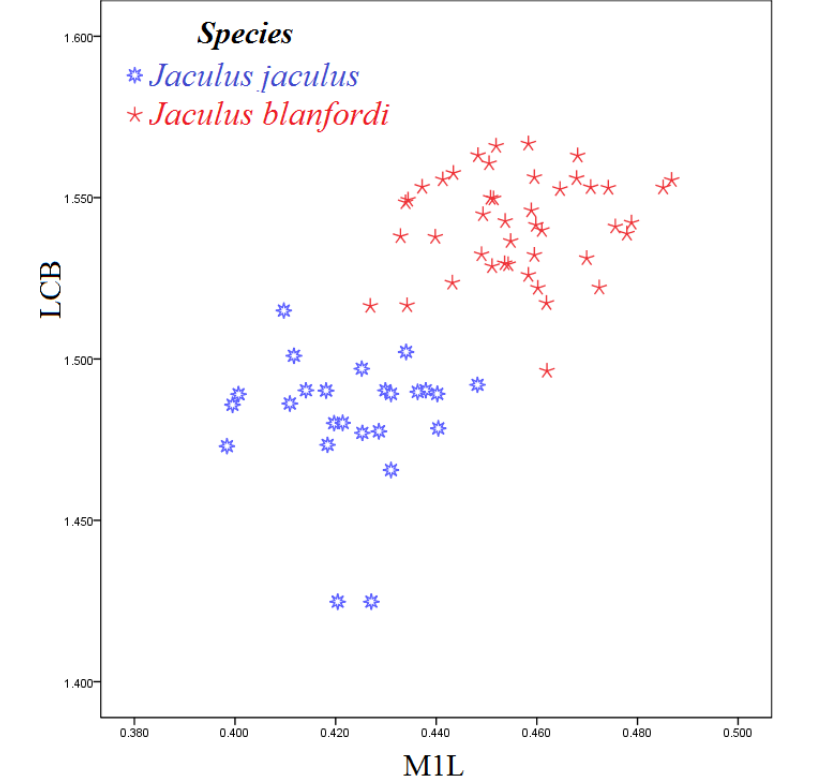
F IGURE 4 . Projection specimens belonging to two species on pictogram of two morphometric characters LCB (length of condilobasal) and M1L (length of first upper